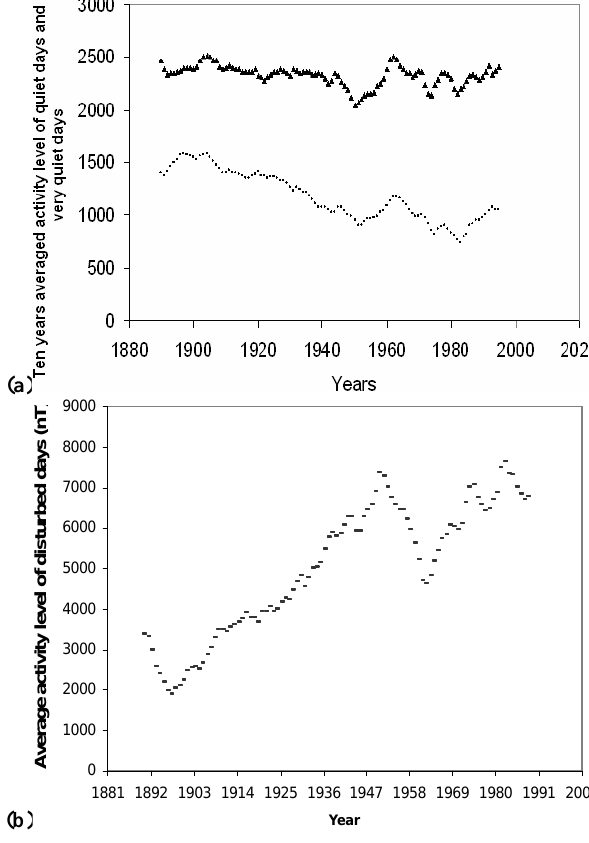
Fig. 4. (a) 10-year running average of the sum of the daily indices during quiet days (Aa < 20nT; line of triangles) and very quiet days (Aa < 13nT; dotted line), with a sliding step of one year; (b) 10-year running average of the sum of the daily indices during disturbed days (Aa ≥ 20nT), with a sliding step of one